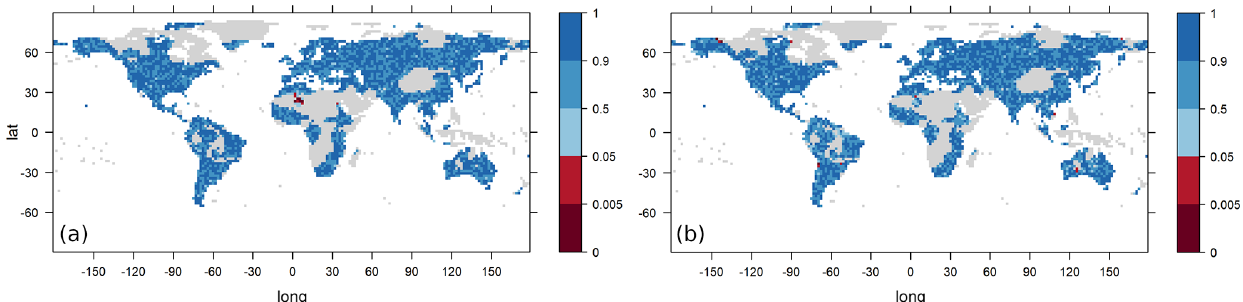
Figure 3. The p values of Kolmogorov–Smirnov tests for the hypothesis that the data follow a GEV distribution with parameters estimated using probability-weighted moments. Test results for the AWI-ESM climate model (a) and for the CRU TS4.04 reanalysis data (b) .